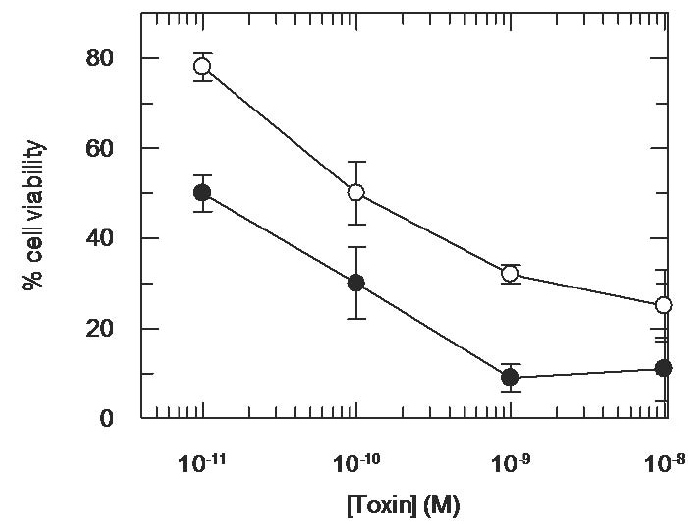
Figure 7. Seventy-two hour Cytotoxicity of CD7-SAP for HSB-2 cells after incubation in the presence or in the absence of Chloroquine (Chl, 5  M). HSB-2 cells were incubated with CD7-SAP for 72 h in the presence or in the absence of 5  M chloroquine. Percent cellular viability refers to control untreated cells. Measures have been performed in ○ ● CD7-SAP, CD7-SAP+ quadruplicate cultures. Symbols are as follows: